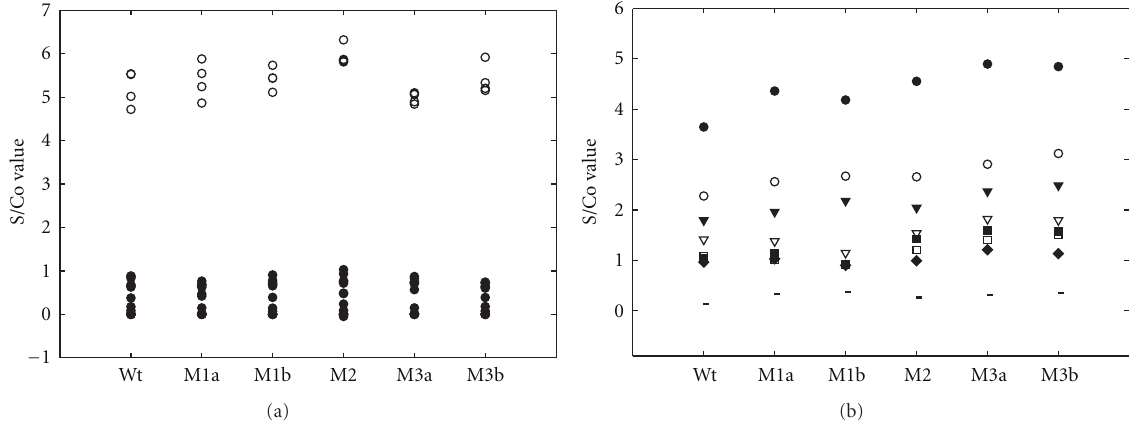
Figure 2: HCV ELISA for urea-denatured HCV core mutants. The urea-denatured HCV core antigens (100 μ L of 4 μ g/mL per well) were used to coat the microplate for the detection of anti-HCV antibody of BBI panel (a) and GBC inhouse panel (b). The absorbance data were compiled statistically as S/Co value (S: sample value; Co: cut-o ff value). The cut-o ff value was calculated as the negative control OD plus positive control OD divided by 4 (Co = NCx + PCx / 4). The positive samples (i.e., S/Co > 1, marked as open circle, lot number HCV10165-6 ∼ 9) could be clearly separated from the negative samples (i.e., S/Co < 1, marked as closed circle, lot number HCV10017-1 ∼ 7, HCV10026-1 ∼ 5, HCV10058-1 ∼ 3) of BBI panel. In Figure 2(b), the primary antibodies used are sequentially diluted in 10-fold order from